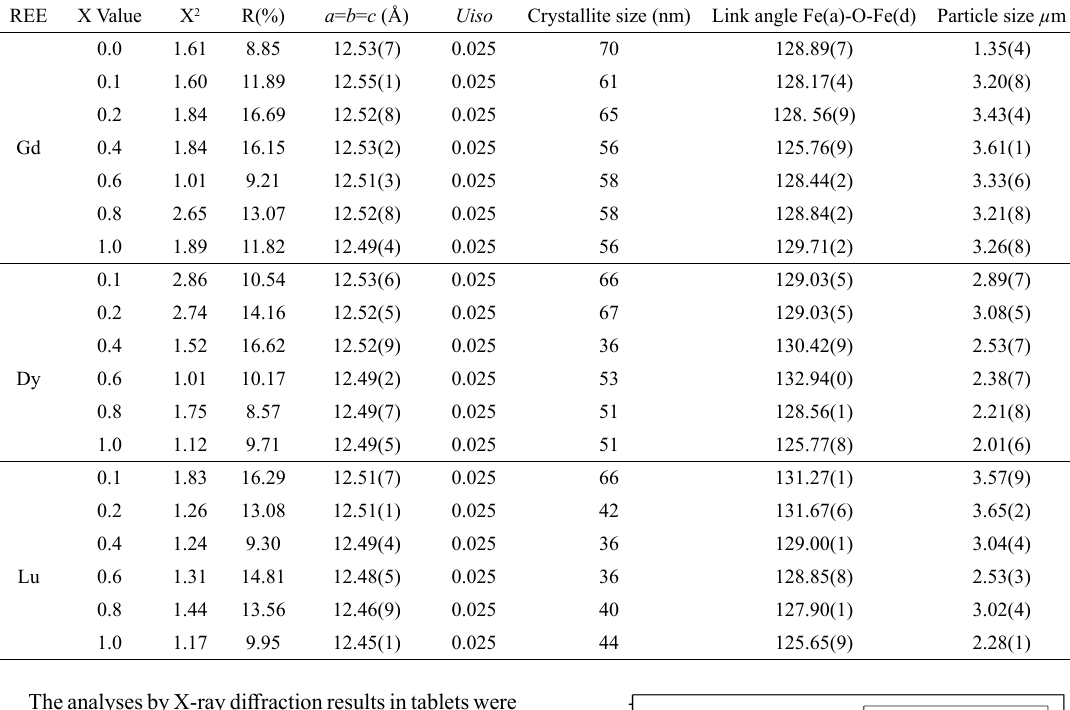
REE Fe O . 3− x x 5 12